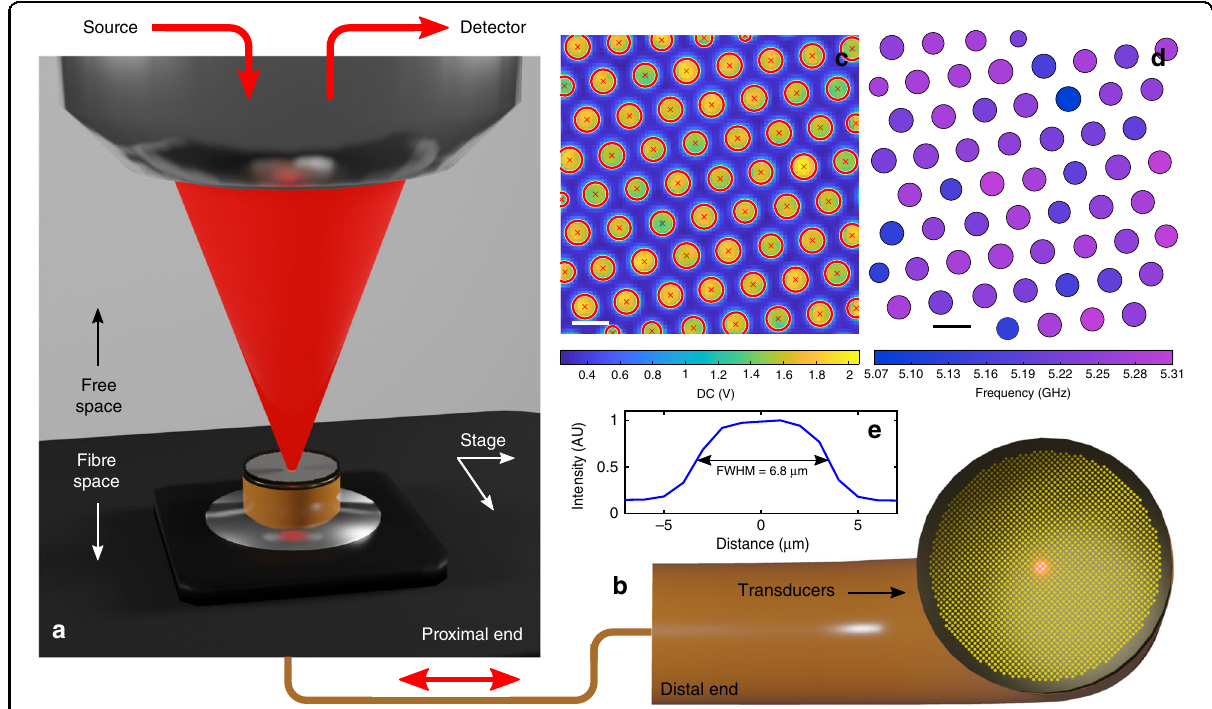
Fig. 6 Time resolved Brillouin scattering with a standard optical fi bre imaging bundle. a , b Proximal and distal ends of the phonon imaging bundle; distal facet contains 18,000 transducers. Each core serves as a pixel which is read-out sequentially through proximal scanning. c Optical intensity (DC) map for centroiding the cores. Calibration of core positions in c allows quick scanning and measurement of TRBS and Brillouin frequency (in water) at the distal end ( d ). e Optical intensity distribution along the cross-section of a single core in c . Scale bars are 10 μ